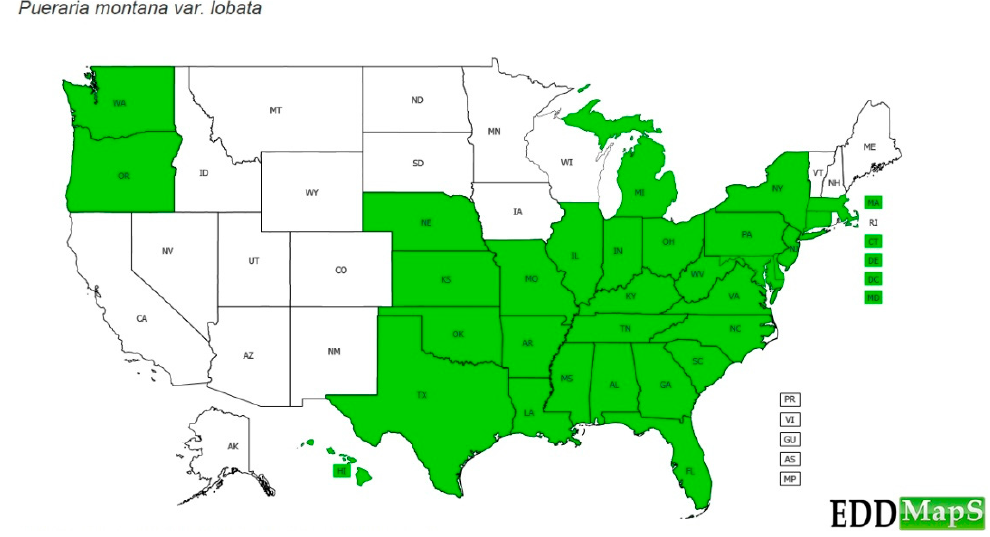
Figure 1. Distribution map of kudzu ( P. montana ) in the United States [12]. no data; species reported.